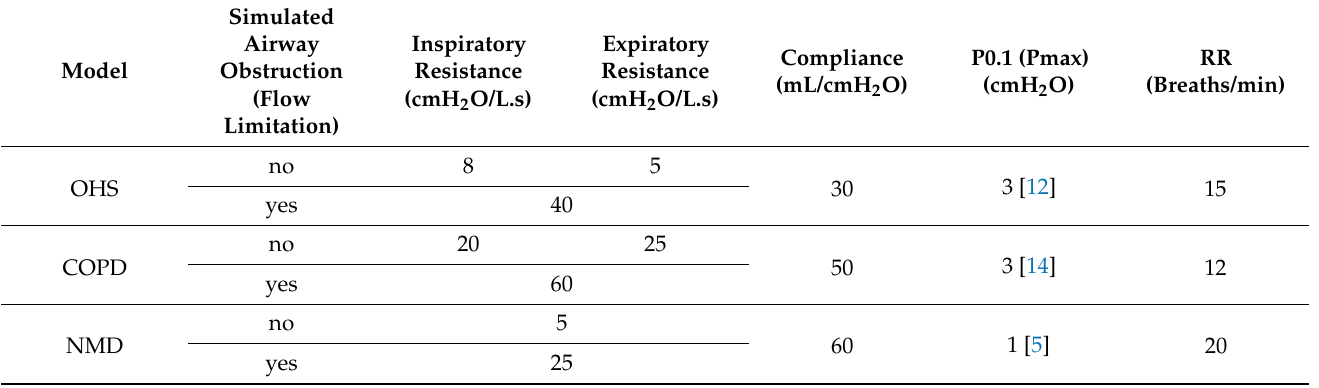
Table 1. Parameters used to simulate pulmonary mechanics and respiratory dynamics with the mechanical